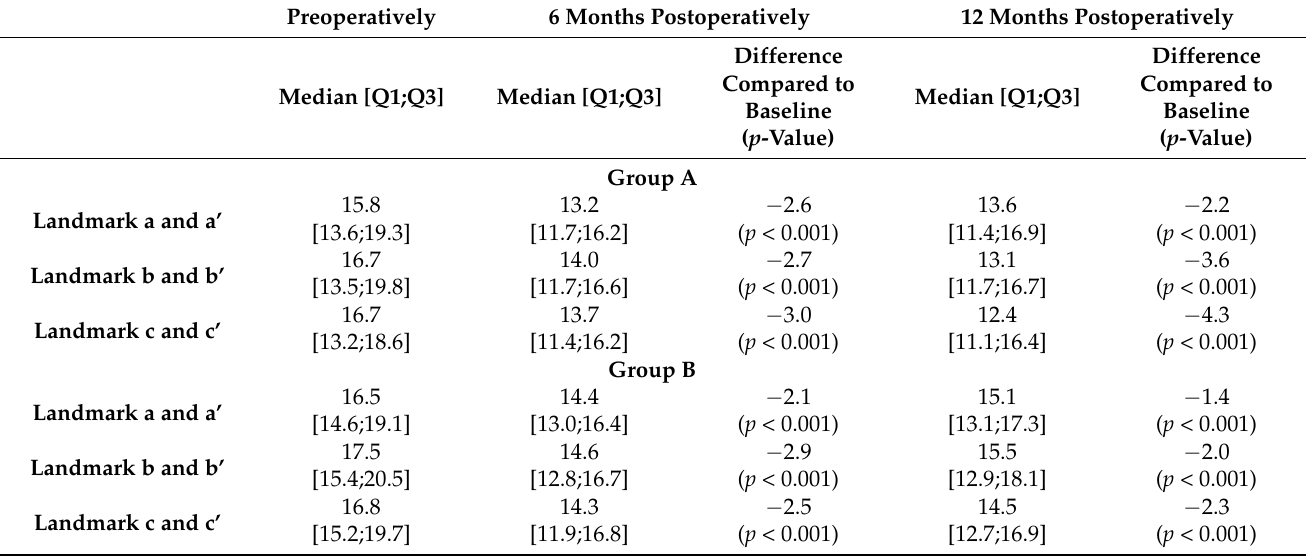
Table 4. Eyebrow height in millimetres (median[Q1;Q3]): pre-and postoperative differences.